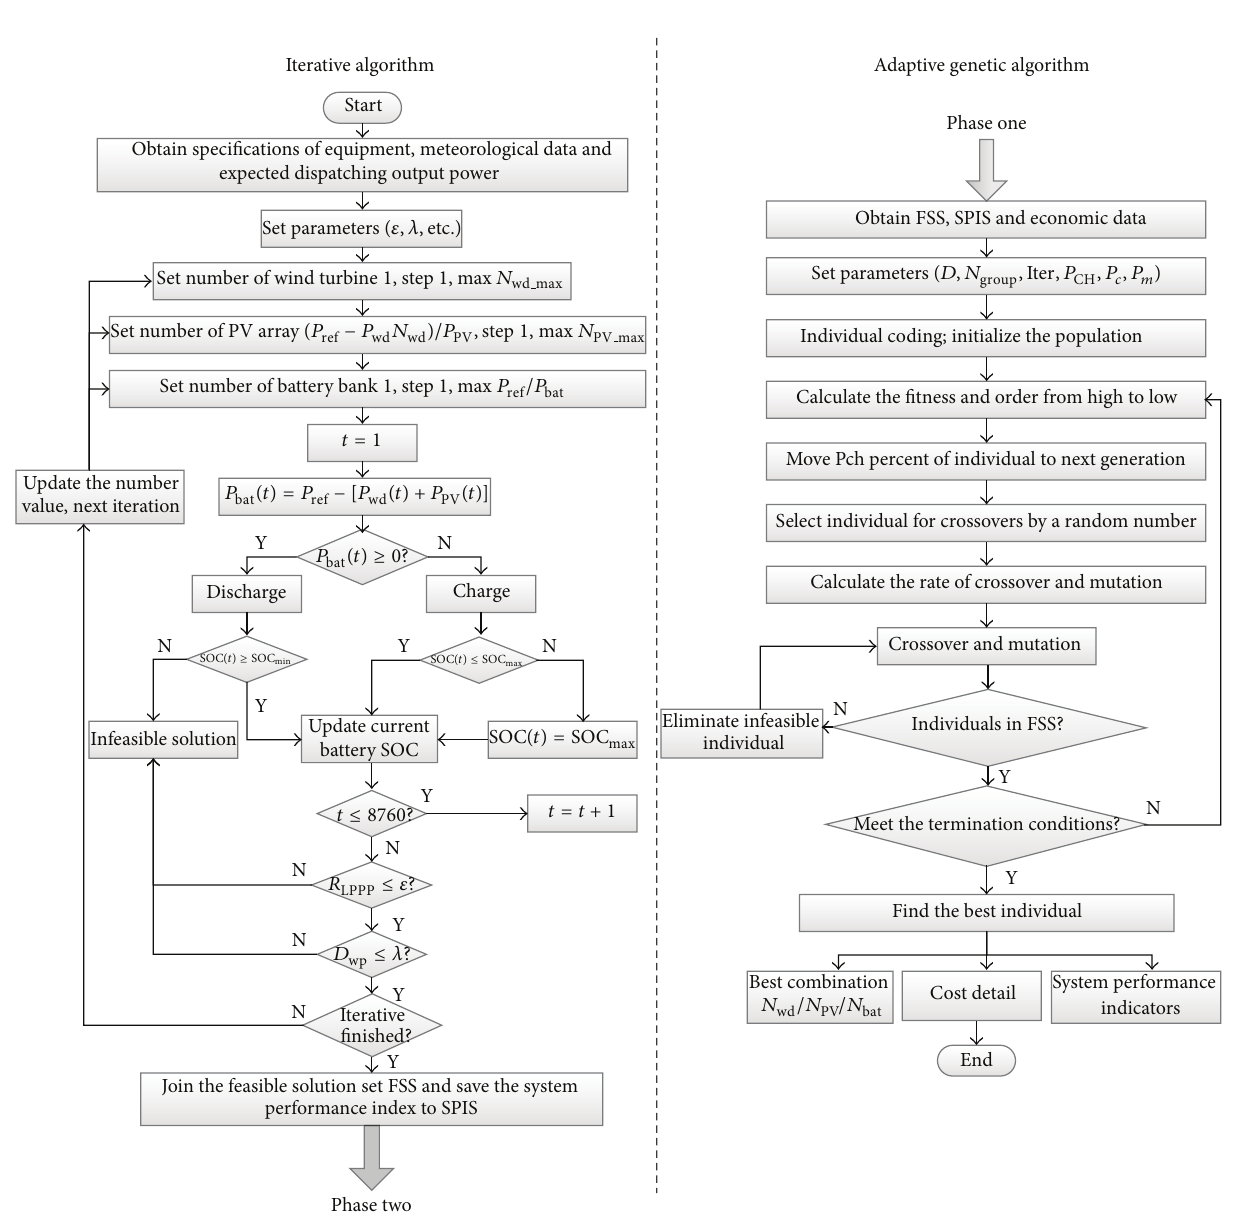
Figure 5: The HIAGA